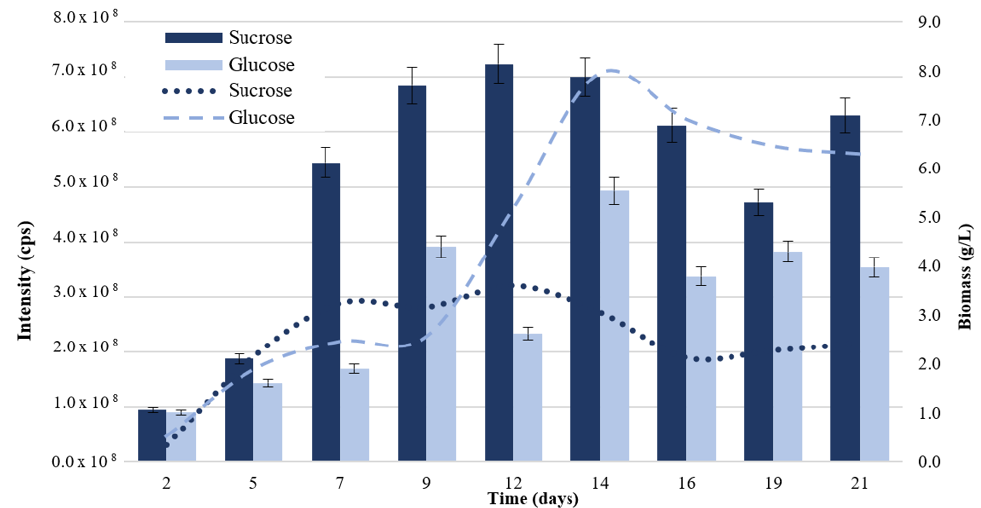
Figure 1. Production of P aib (bars) and biomass (lines) of T. asperellum according to the carbon source added to the culture medium. Intensity values on the left axis are relative to P aib production.